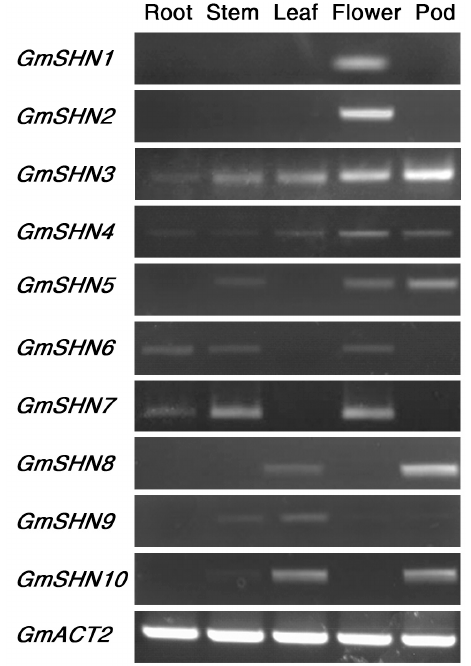
Figure 3. Organ expression patterns of soybean SHN genes. All 10 members of soybean SHN genes were analyzed by reverse transcription polymerase chain reaction (RT-PCR) in various organs from soybean plants. GmACT2 was used as control.